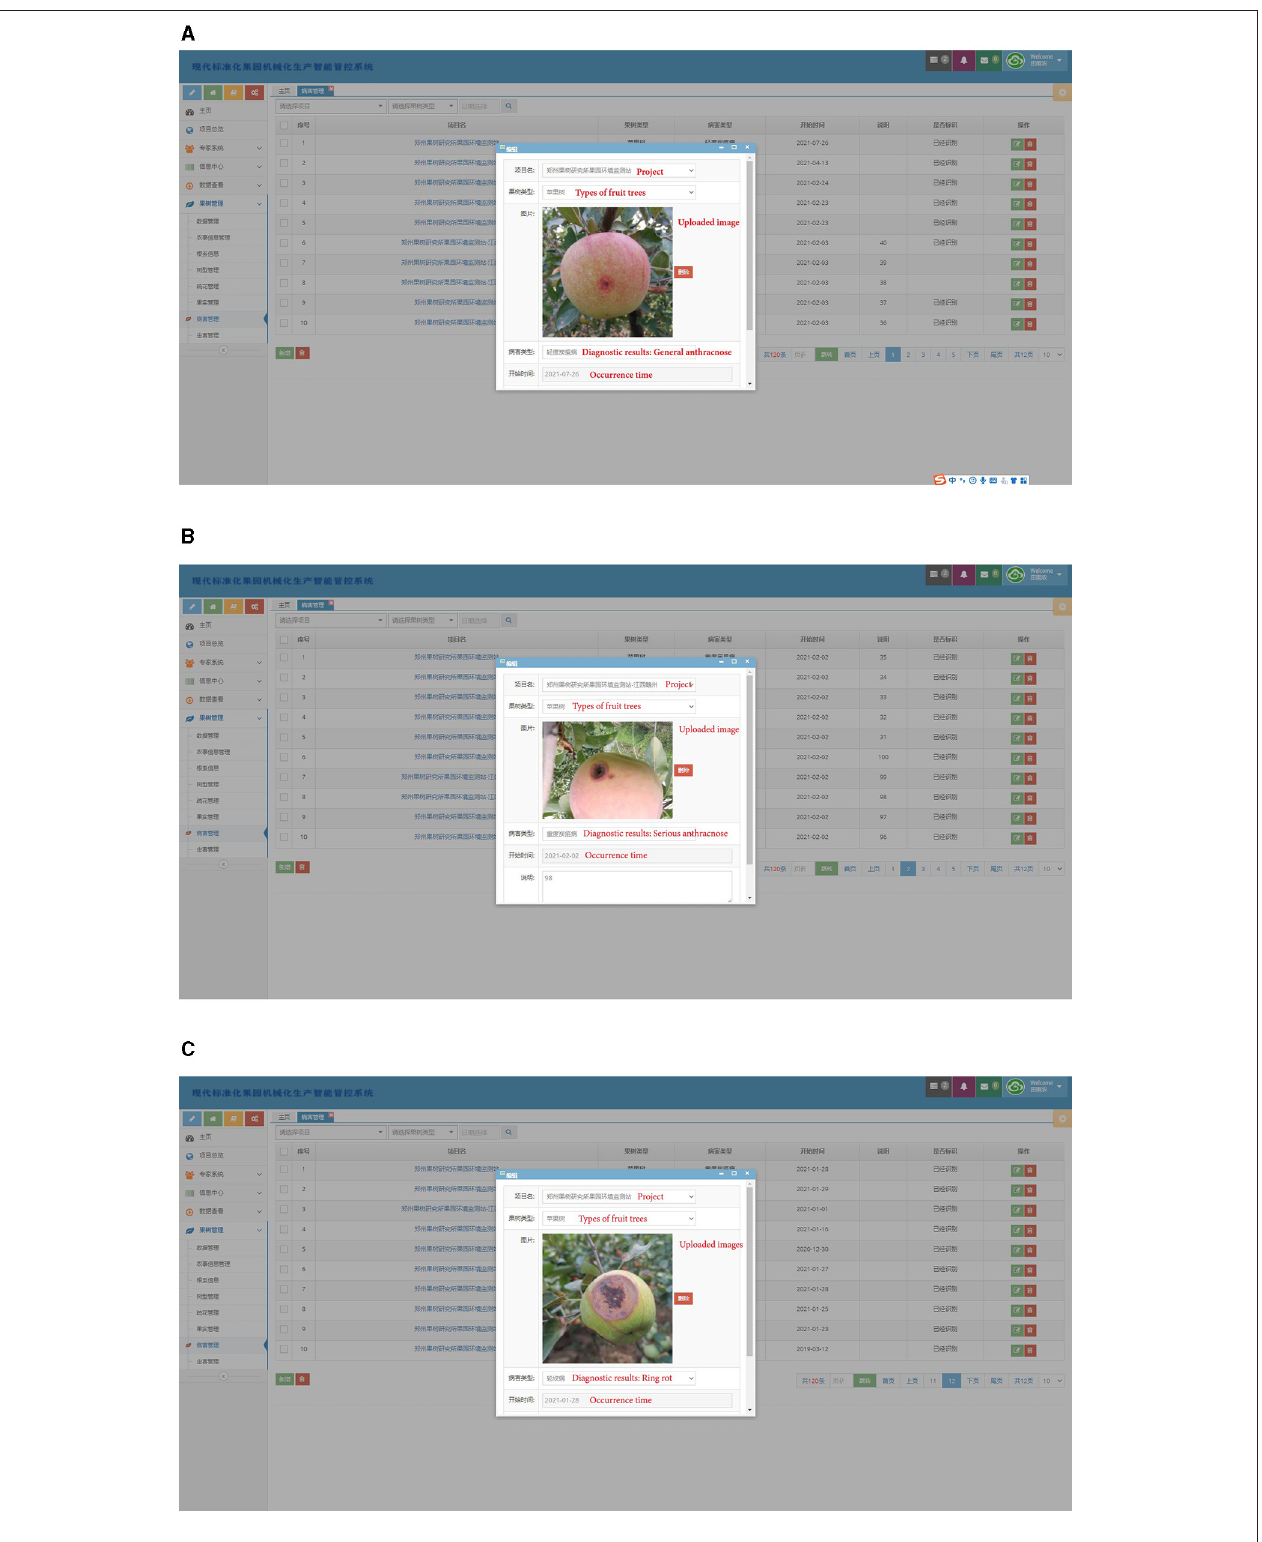
FIGURE 10 | Several diagnosis results in practical application scenarios. (A) General anthracnose, (B) serious anthracnose, (C) ring rot.